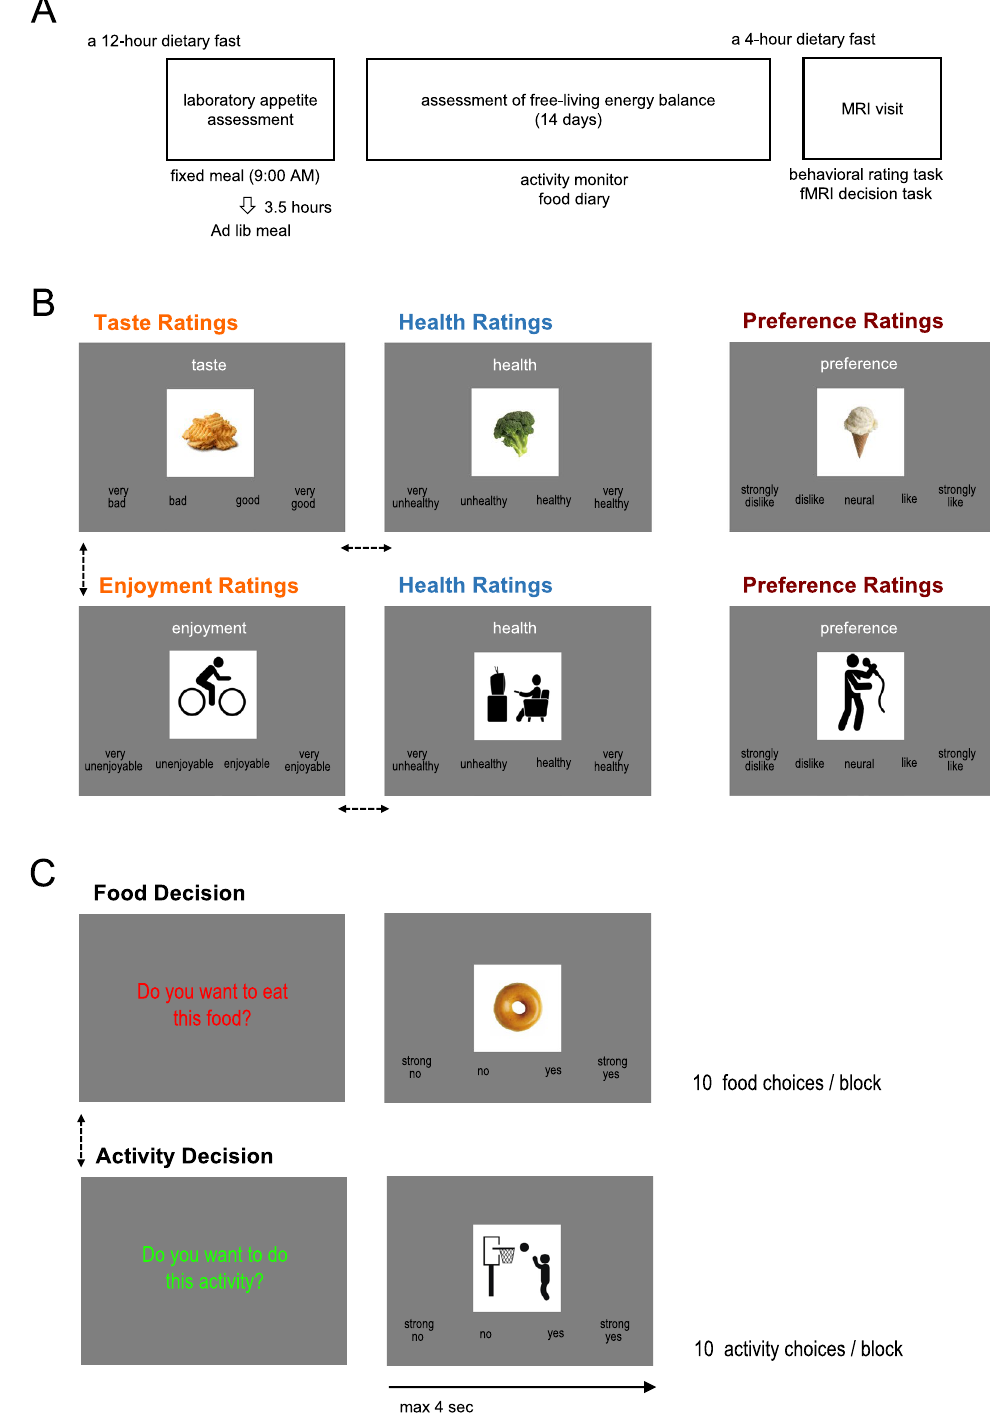
Figure 1. (A) Overview of the study design. ( B ) Adolescents completed food and activity ratings before fMRI scans. They provided taste and health attributes and overall preference ratings for 60 different food items, and enjoyment and health attributes and overall preference ratings for 60 different activity items. The order of food and activity rating tasks and the order of attribute ratings within each type of task were randomized. ( C ) fMRI decision task consisted of activity and food decision blocks. Participants completed 6 runs of the decision task and each run included 3 food and 3 physical activity choice blocks (10 decision trials per block). Computer algorithms randomized the order of blocks and the order of trials within the block. For each food and physical activity image, participants entered their decisions using a 4-point scale (“strong no–strong yes” or “strong yes– strong no”; counterbalanced across participants) within